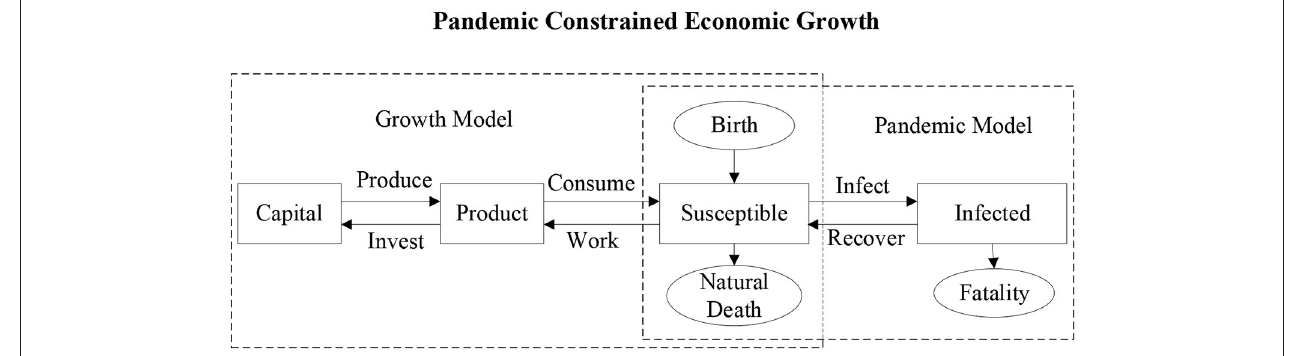
FIGURE 1 | Interdisciplinary theoretical